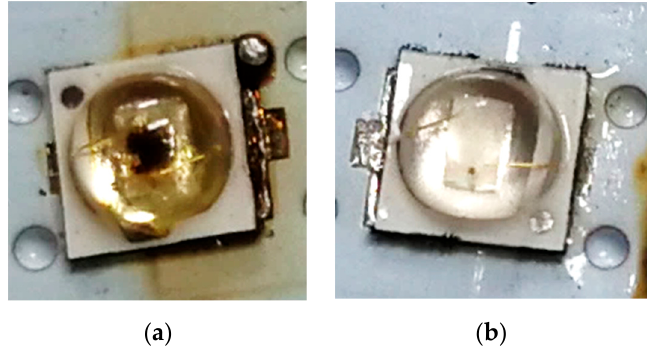
Figure 14. ( a ) A failed and ( b ) an unburnt sample of the investigated mid-power LEDs.